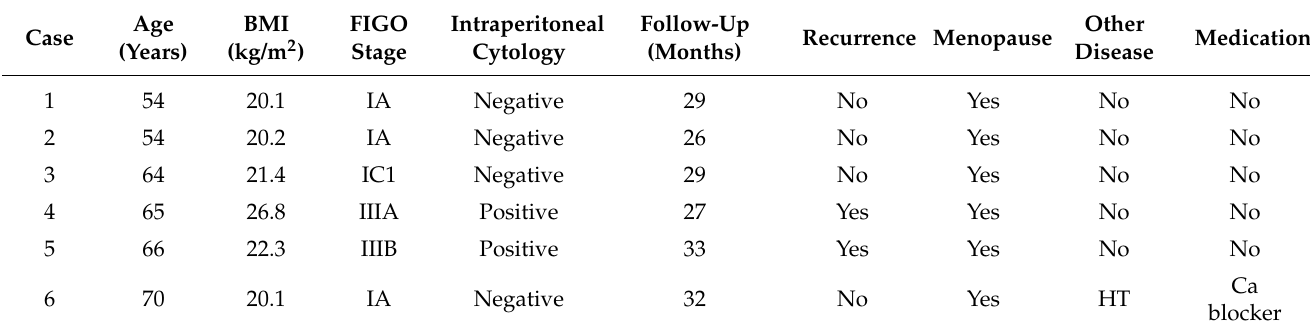
Figure 2. MiRNA microarray analysis was performed to Te-EVs obtained from OCC specimens and normal ovaries. Scatter plot of miRNA signal values showing the miRNA expression variation between the cancerous and normal samples. The values spotted in the x- and y-axes represent the normalized signals of samples in the two groups (log2-scaled). The solid lines represent fold changes. The miRNAs above the upper solid line and below the lower solid line are those with a >2-fold change in expression levels between the cancerous and normal-appearing tissues. The cross marks indicate that the miRNAs are two-fold or higher overexpressed in the cancerous region compared with the normal region. ( A ) 255 miRNAs were detected in case 1. ( B ) 342 miRNAs were detected in case 2. ( C ) 90 miRNAs were detected in case 3. ( D ) 272 miRNAs were detected in case 4. ( E ) 37 miRNAs were detected in all four cases. Table 1. Characteristics of six patients with ovarian clear cell carcinomas.